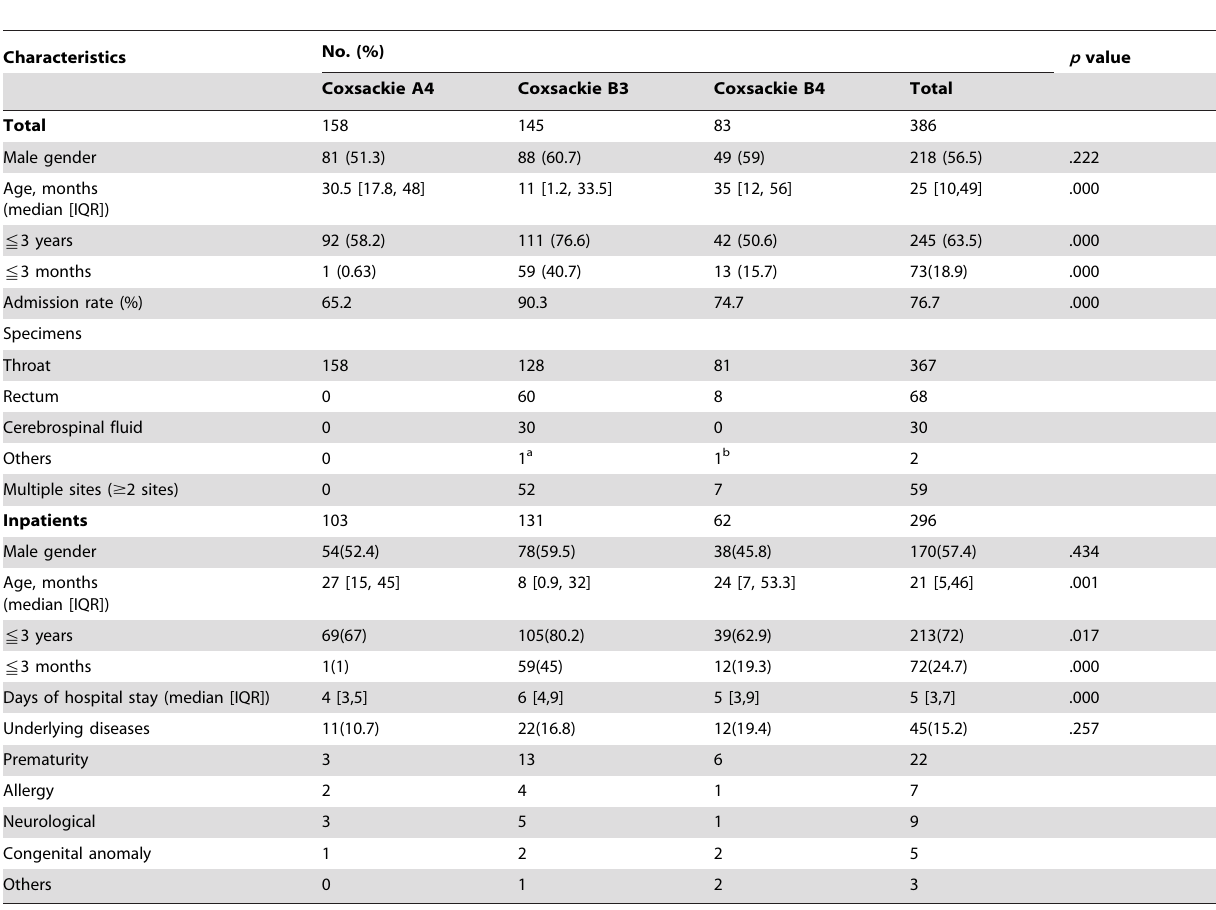
Table 1. Demographics of 386 children with Coxsackievirus A4, B3 and B4 infections in Chang Gung Memorial Hospital, January, 2004–June, 2012.